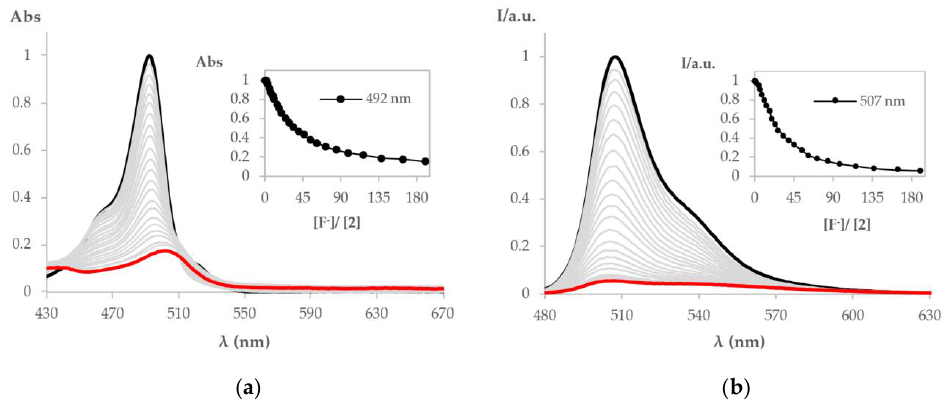
Figure 3. ( a ) Spectrophotometric and ( b ) spectrofluorimetric titration spectra of BODIPY derivative 2 upon addition of increasing quantities of F − (0 eq. — black line, to 190 eq. — red line) in acetonitrile. Inset: normalized absorbance and emission intensities at 492 nm and 507 nm, respectively, as a function of [F − ] / [ 2 ].